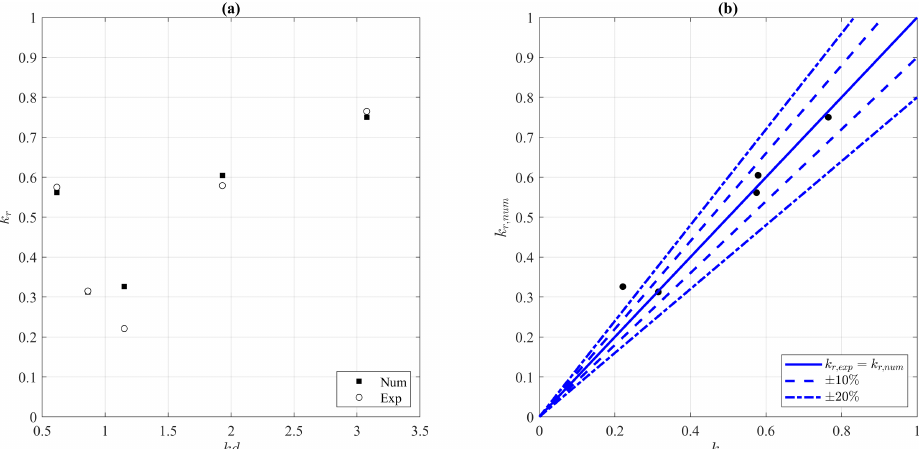
Figure 5. Reflection coefficient: ( a ) reflection coefficient measured in the experimental campaign and that estimate by the numerical model as a function of the parameter kd ; ( b ) comparison between the reflection coefficient measured in the experimental campaign and that estimated by the numerical model. The dashed lines represent the limits of 10% and 20% usually assumed in previous studies for this kind of comparison.